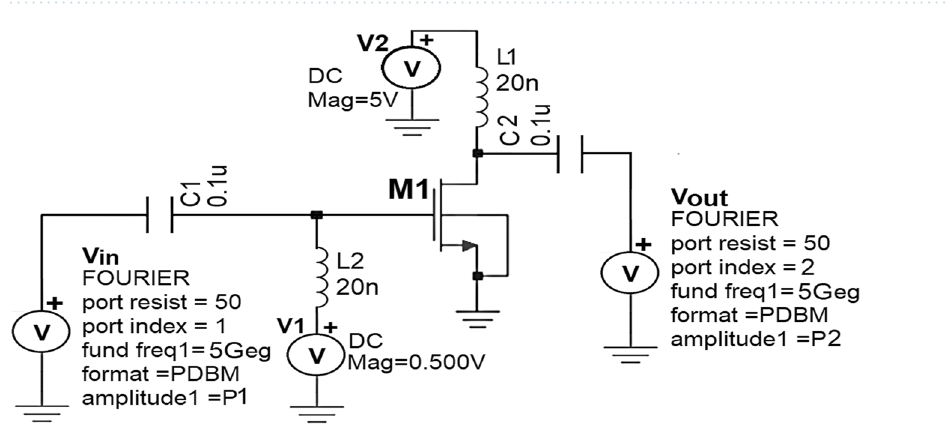
Figure 17. S-Parameter and Z out extraction of nm_hp NMOS transistor at 5 GHz